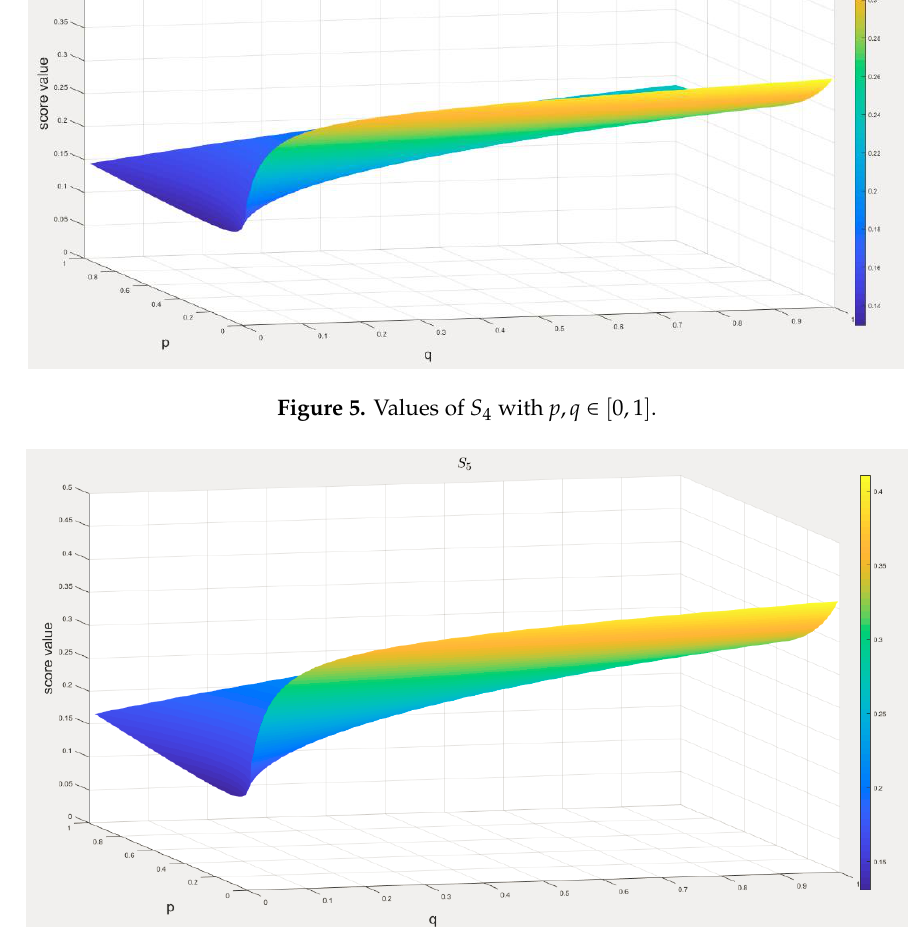
Figure 6. Values of Figure 6. Values of